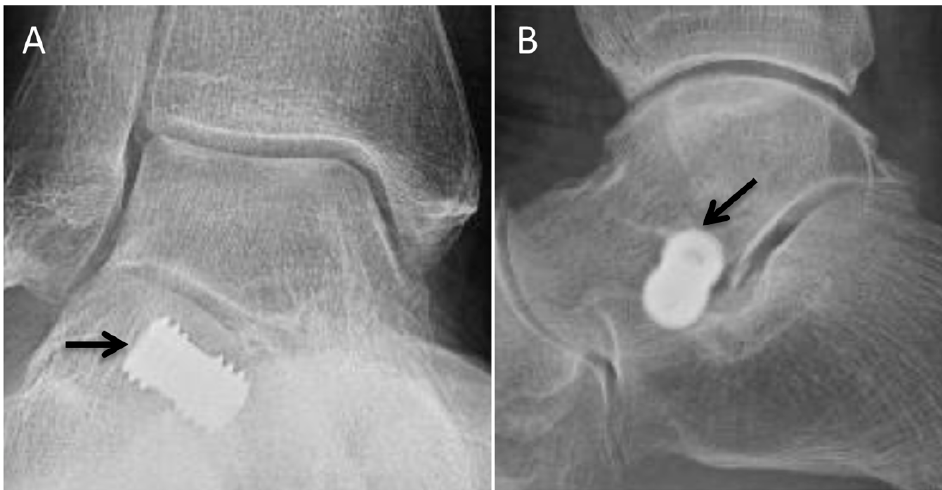
Figure 10. ( A ) AP and ( B ) lateral radiographs demonstrating the arthroereisis screw expanding the subtalar joint (black arrows) positioned between the anterior and posterior subtalar articulations.